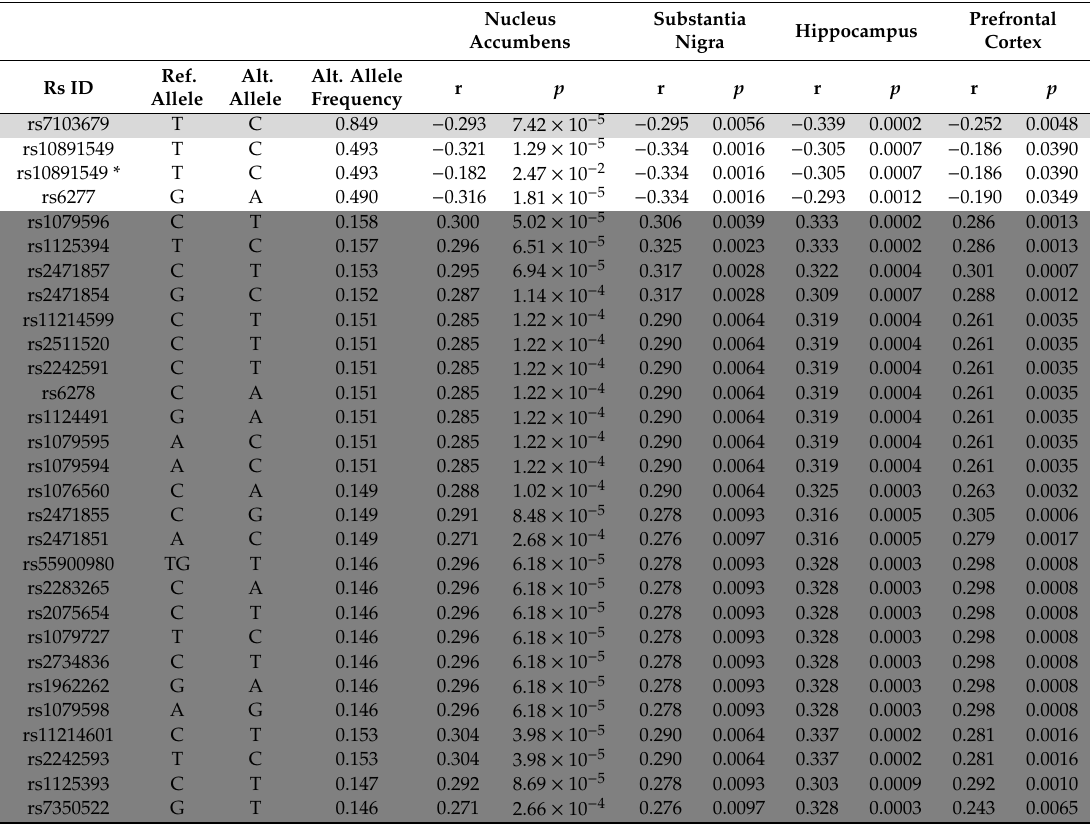
Table 2. Associations of DRD2 genotype variants with expression, by